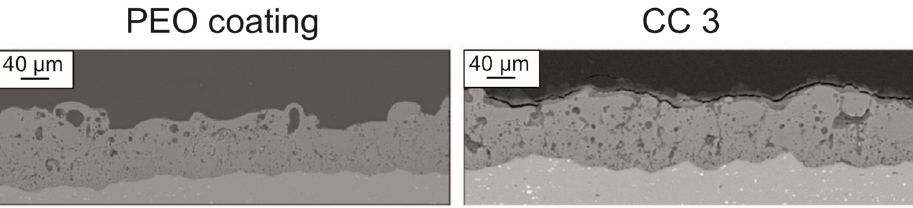
Table 1. Thickness and porosity of PEO and composite coatings formed on aluminum alloy ( d is a coating thickness, and P sur and P cs are surface porosity and porosity within the coatings’ cross-sec- tion, respectively).